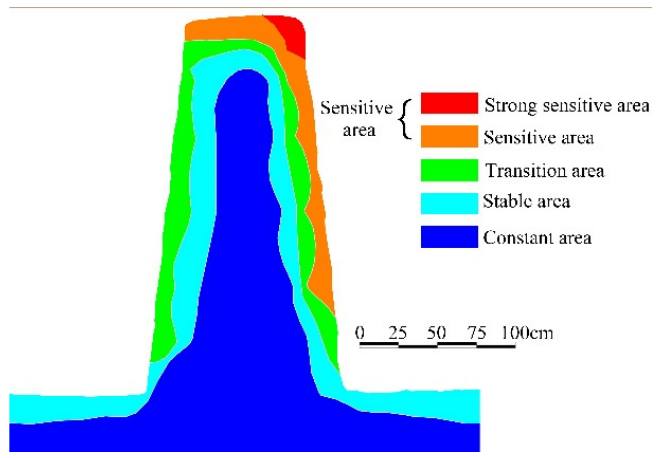
Figure 12. Temperature field of test wall in summer.